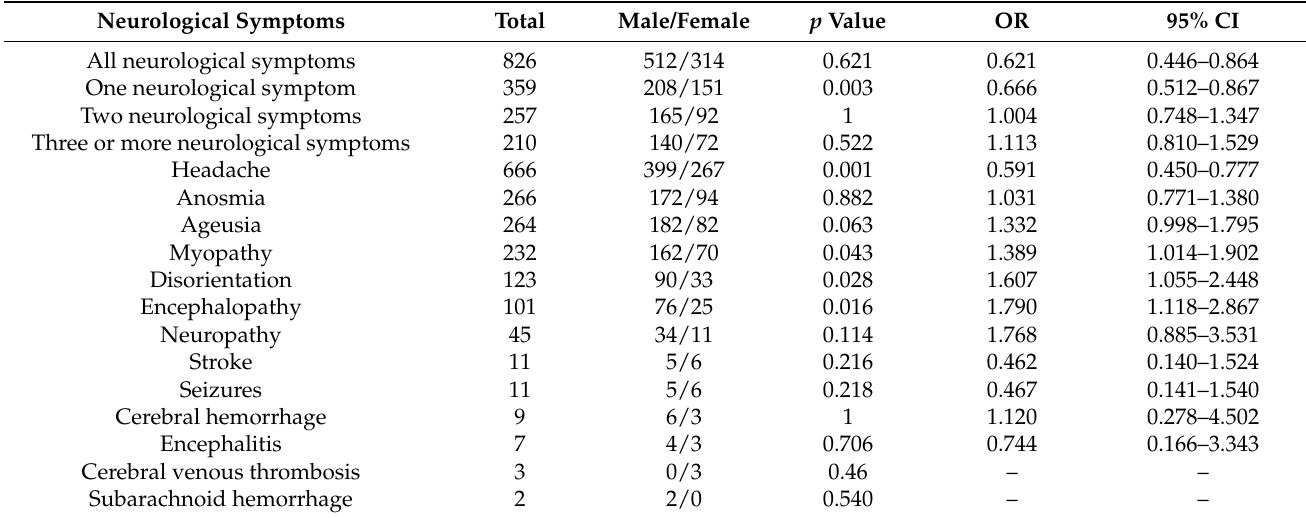
Table 2. Neurological manifestations according to